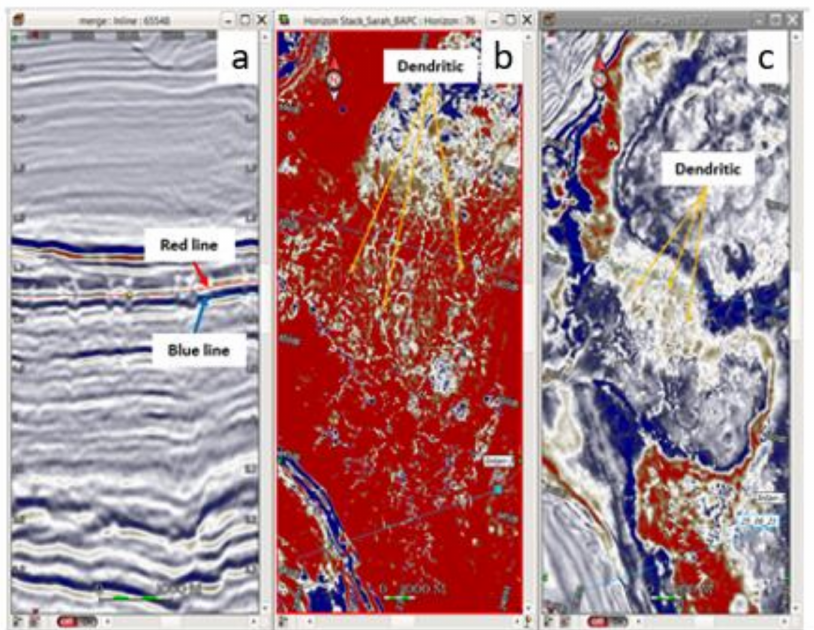
Figure 5. ( a ) Horizon slicing (red line) and time slicing (blue line) shown in the vertical seismic section. ( b ) shows Horizon slice ( c ) shows time slice. Both are applied to image the karst dendritic patterns. Image ( b ) delineates more prominent and shows the continuation of the karst geobody compared to the time slice image ( c ) which could mislead karst interpretation that should be avoided during the well planning decision.